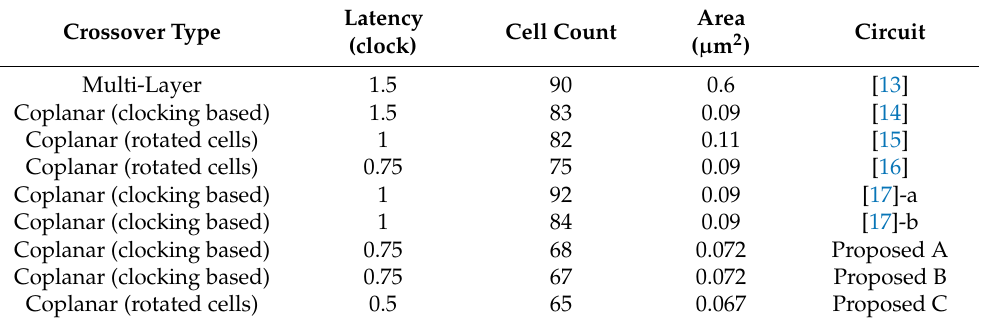
Table 3. Comparing the Full Adder/Subtractor (FA/S) of this study with those of previous